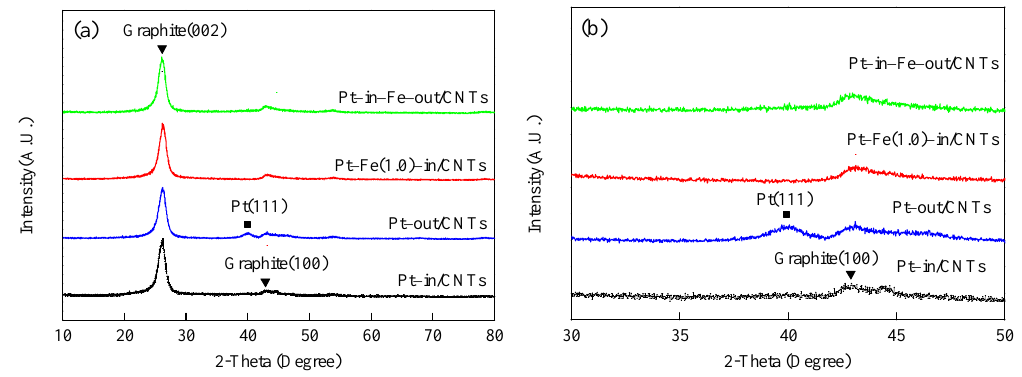
Figure 3. XRD patterns of Pt–in/CNTs, Pt–out/CNTs, Pt–Fe(1.0)–in/CNTs, and Pt–in–Fe–out/CNTs. ( a ) 2 θ = 10–80°, ( b ) 2 θ = 30–50 °.